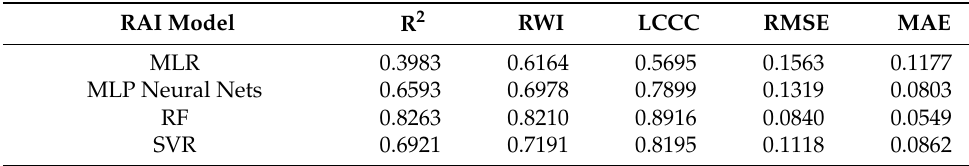
Table 2. Validation results of the RAI model. RAI Model